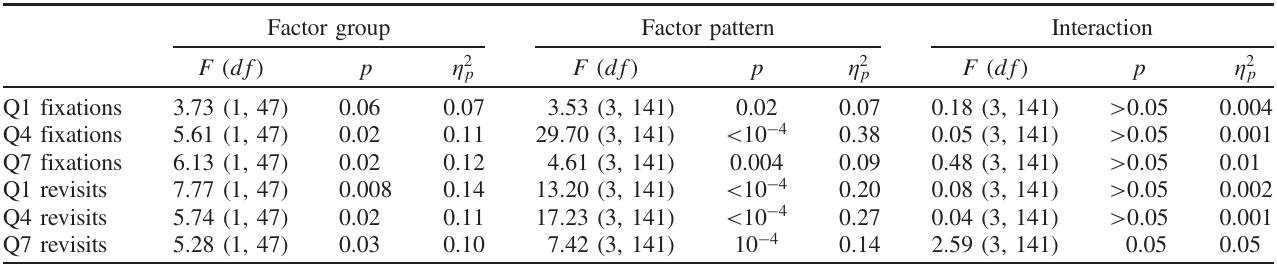
TABLE II. Results of a two-way mixed-design ANOVAs with factors group (experimental vs control) and pattern (e.g., single slit vs double slit vs three slits vs diffraction grating), conducted for a number of fixations and revisits for questions Q1, Q4, and Q7. Factor group Factor pattern